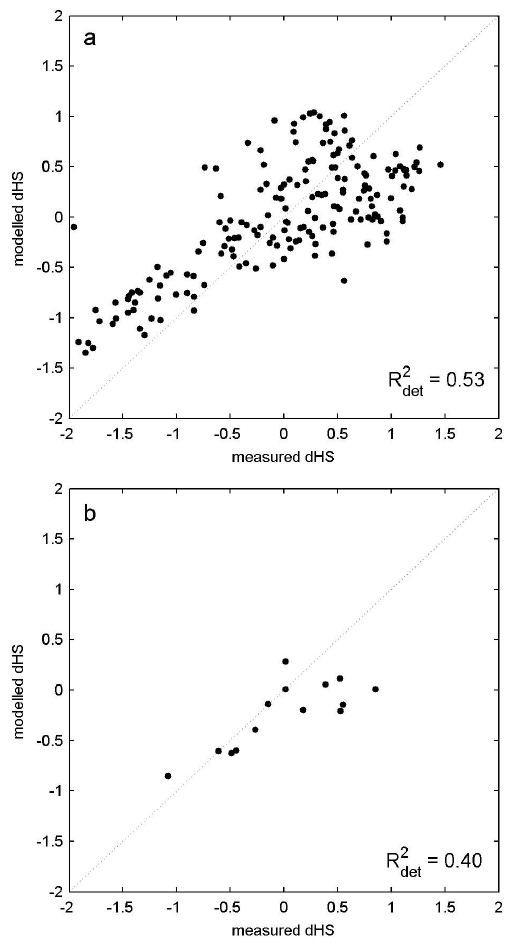
Fig. 7. Measured vs. modelled (parameters: d E , SL and NO) dHS for (a) HEF and (b) WAN. For HEF, the snow depth data obtained in May 2003 are validated in a model calculated with the data from May 2002, June 2002 and May 2009. For WAN, the model from 2009 is validated with data from